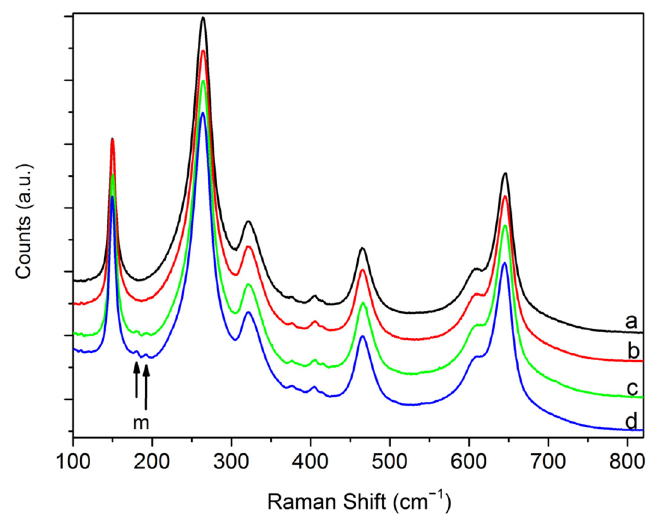
Figure 5. Raman spectra measured with the micro-Raman equipment (as described in the text). Ceramic surface (a); on fracture in dense sample BB05 (b); on a fracture in 13% porous ceramic BB06 (c); on a fracture in 47% porous ceramic BB07 (d). The arrows mark the bands that identify the monoclinic phase.